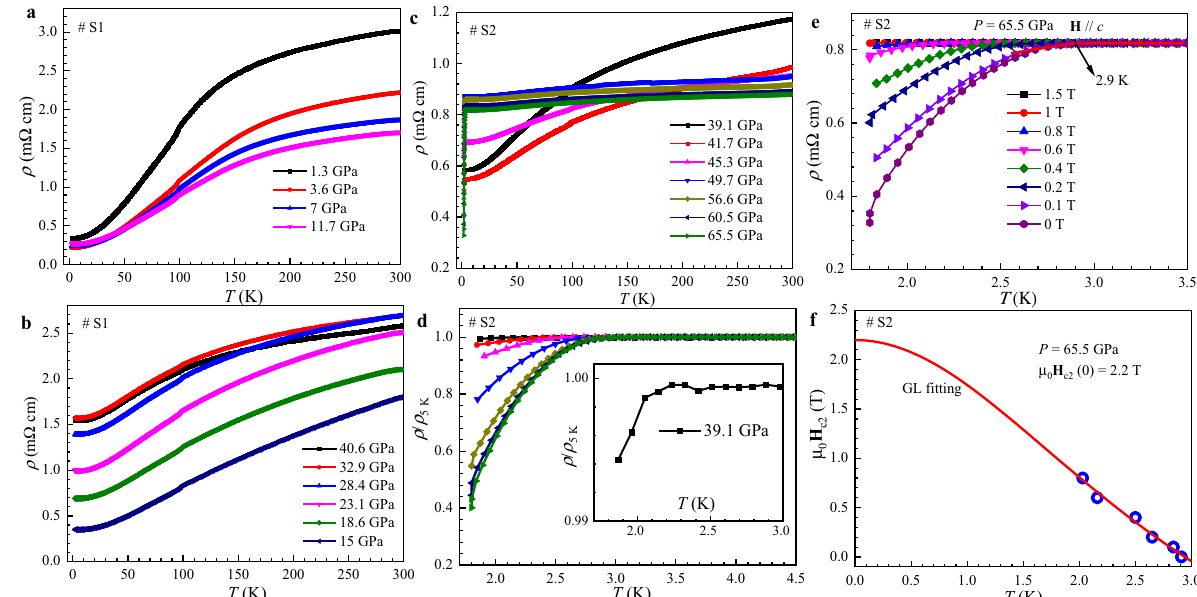
Fig. 2 Pressure-induced superconductivity. a , b ρ ( T ) curves collected on sample 1 under pressures up to 40.6 GPa. c Pressure-induced superconductivity under higher pressures above 39 GPa. d Normalized ρ ( T ) around superconducting transition, and the inset is the expanded view at 39.1 GPa. e , f Upper critical magnetic fi eld measurements with fi eld along the c -axis under pressure 65.5 GPa. e Superconducting transition under different magnetic fi elds up to 1.5 T. f The obtained upper critical fi eld depicted as a function of temperature. The red line is G-L fi tting curve and blue circles are experimental